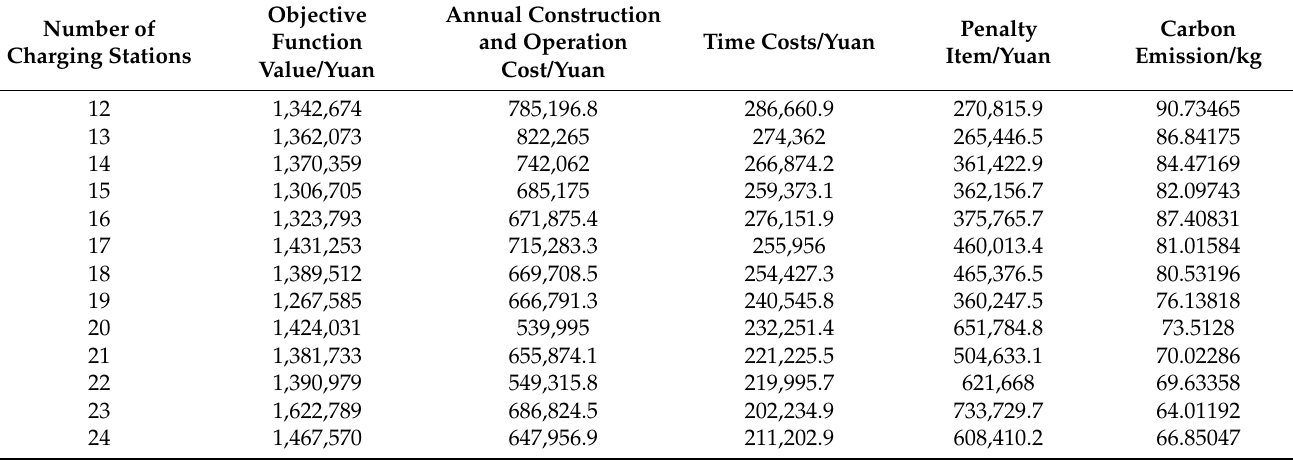
Table 7. Comprehensive cost of charging